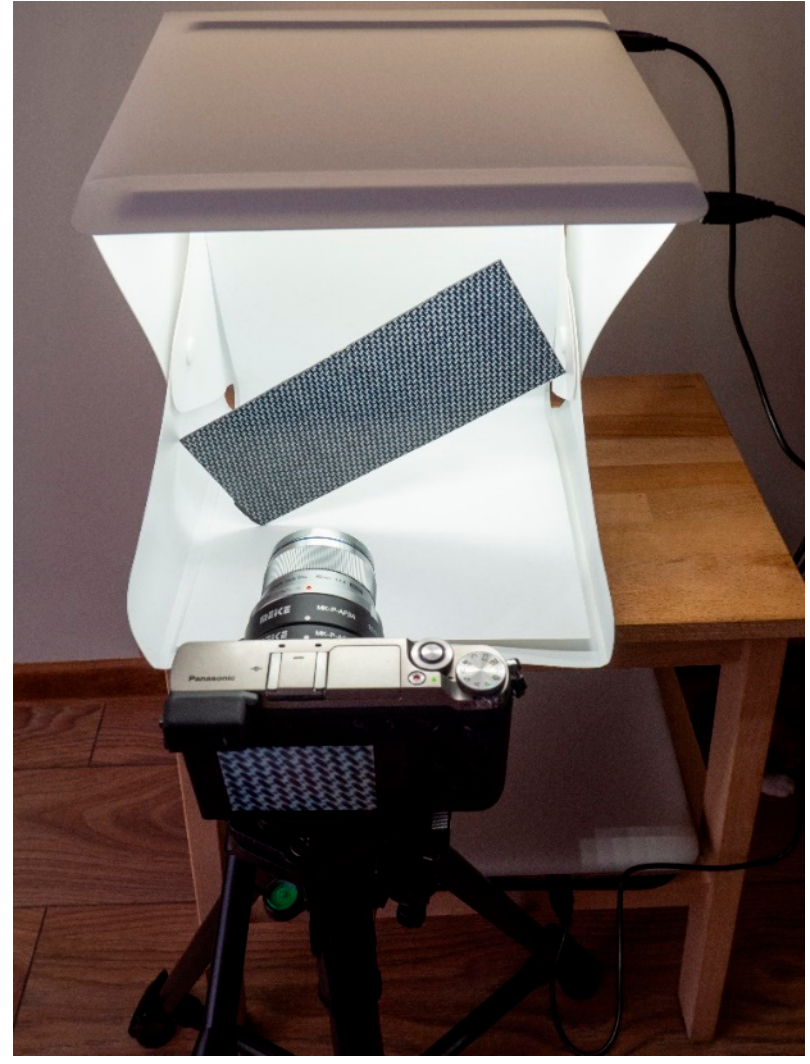
Figure 17. The image acquisition environment used in the automatic detection of SG orientation errors (photographing the composite board).